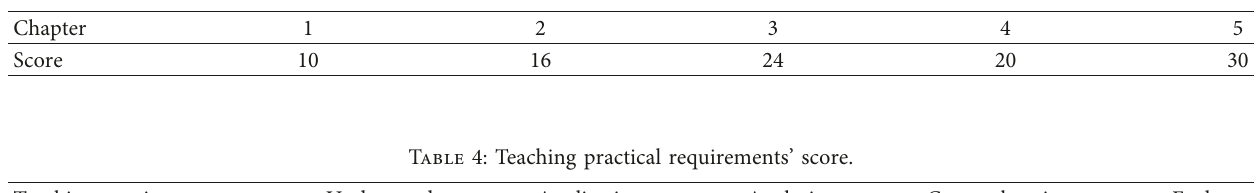
Table 3: Sections.